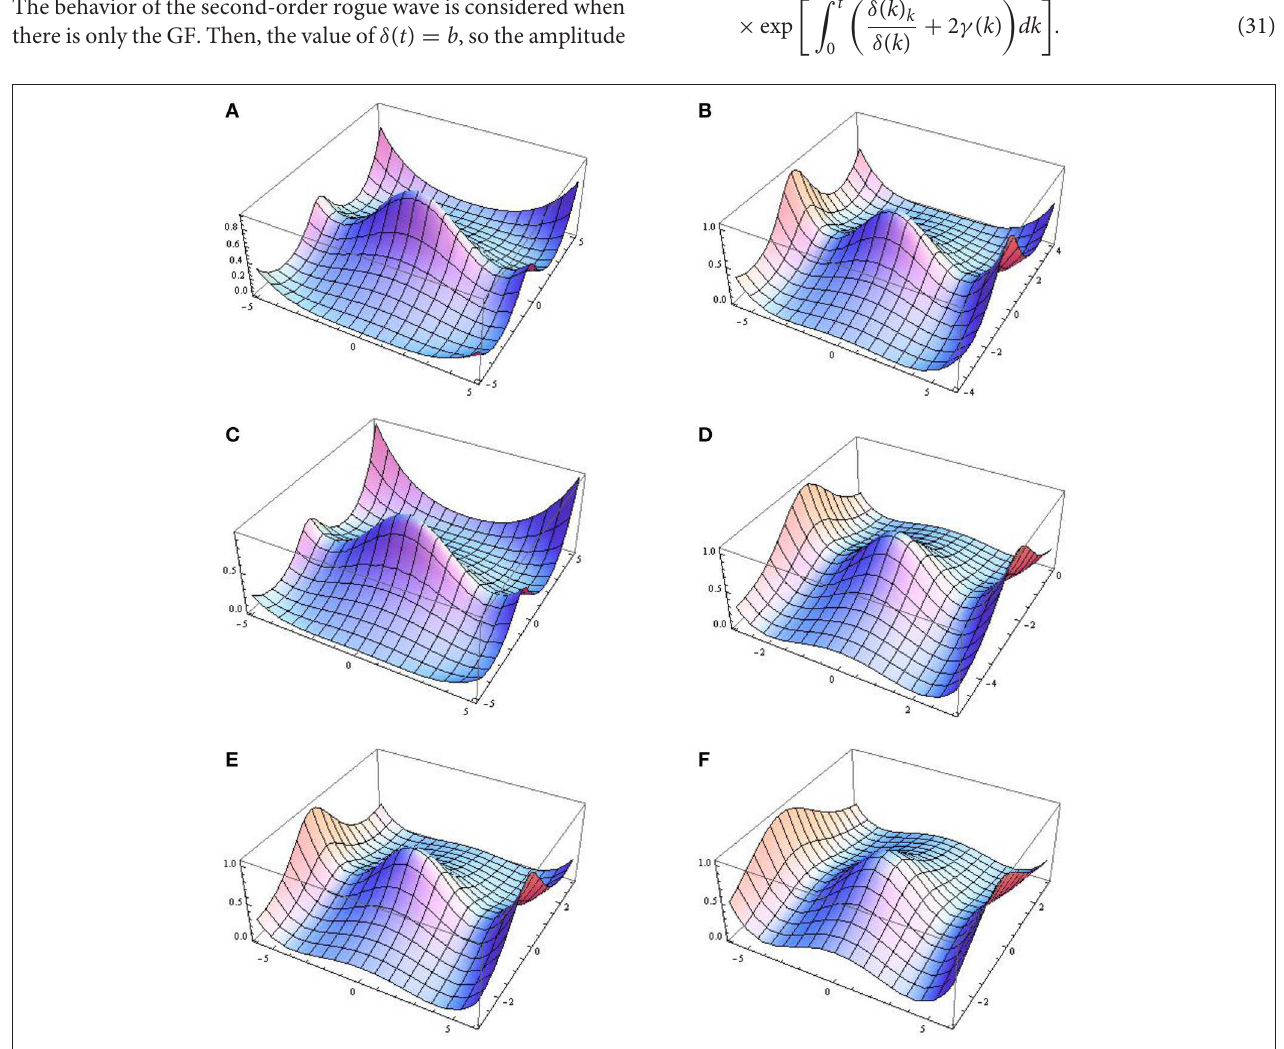
FIGURE 2 | 3D graphical representations of second-order waves. (A) δ ( t ) δ 0 ( t ) 0.2exp( sech (0.2 t )), (D) δ ( t ) = and δ 0 ( t ) 0.35 t 2 =